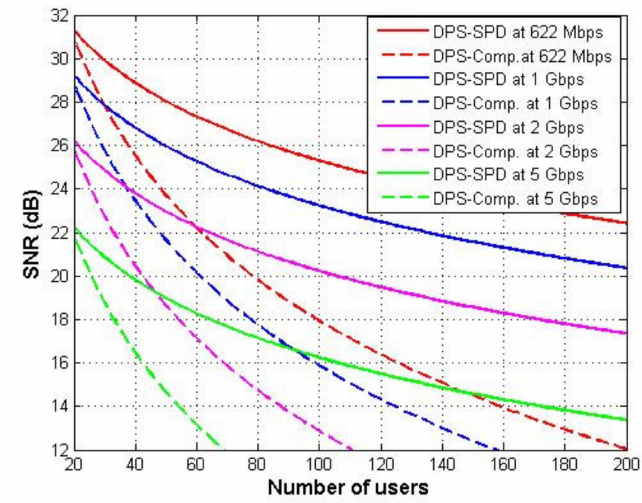
Figure 7. SNR versus number of users for DPS code using different detection techniques at different bit rates Mbps.